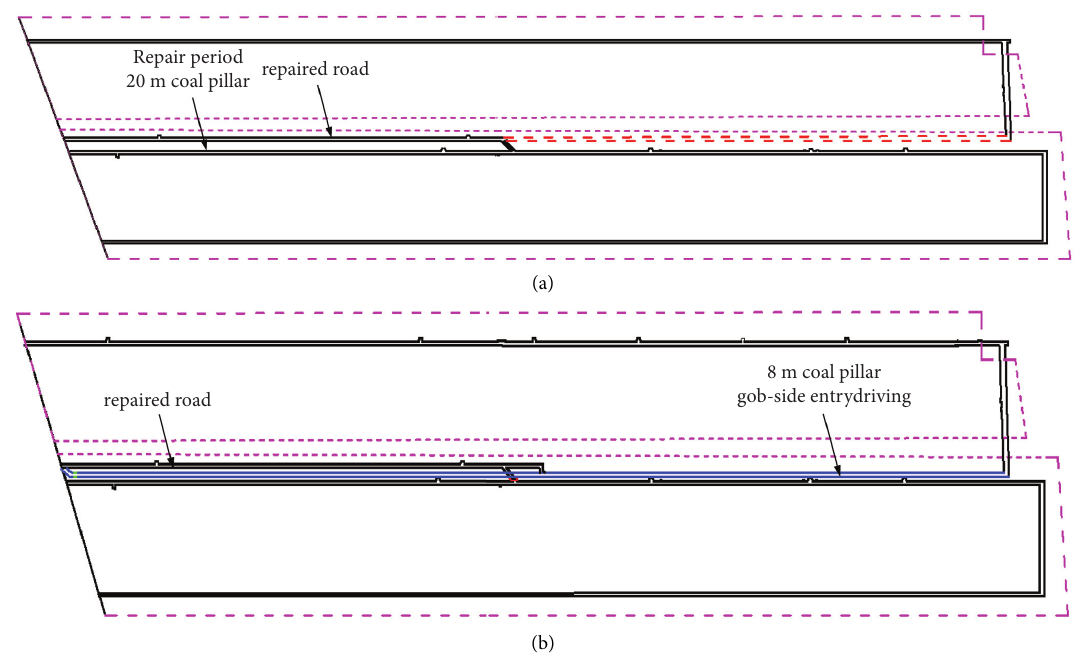
Figure 5: 30503 working face layout scheme. (a) Scheme 1 roadway layout diagram. (b) Scheme 2 roadway layout